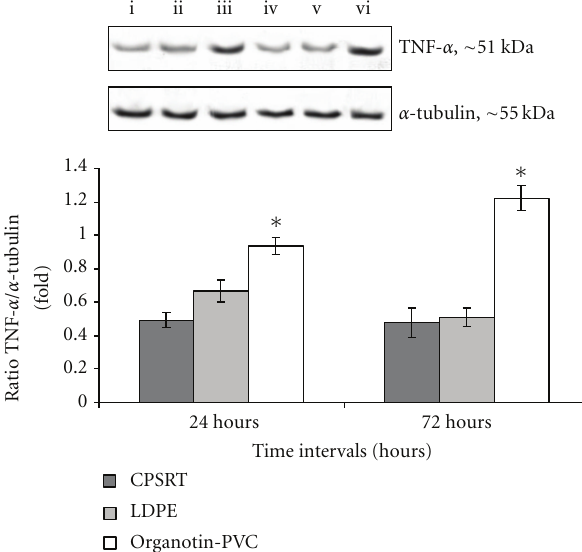
Figure 4: TNF- α protein expression in western blot analysis. pHEK cultures were treated for 24 hours [(i) CPSRT, (ii) LDPE and (iii) organotin-PVC] and 72 hours [(iv) CPSRT, (v) LDPE and (vi) organotin-PVC] ( n = 3). ∗ For P ≤ 0 . 05 compared with CPSRT. Similarly, lyophilized chitosan sca ff old coated with collagen (40–100 μ m pore sizes) was shown to have